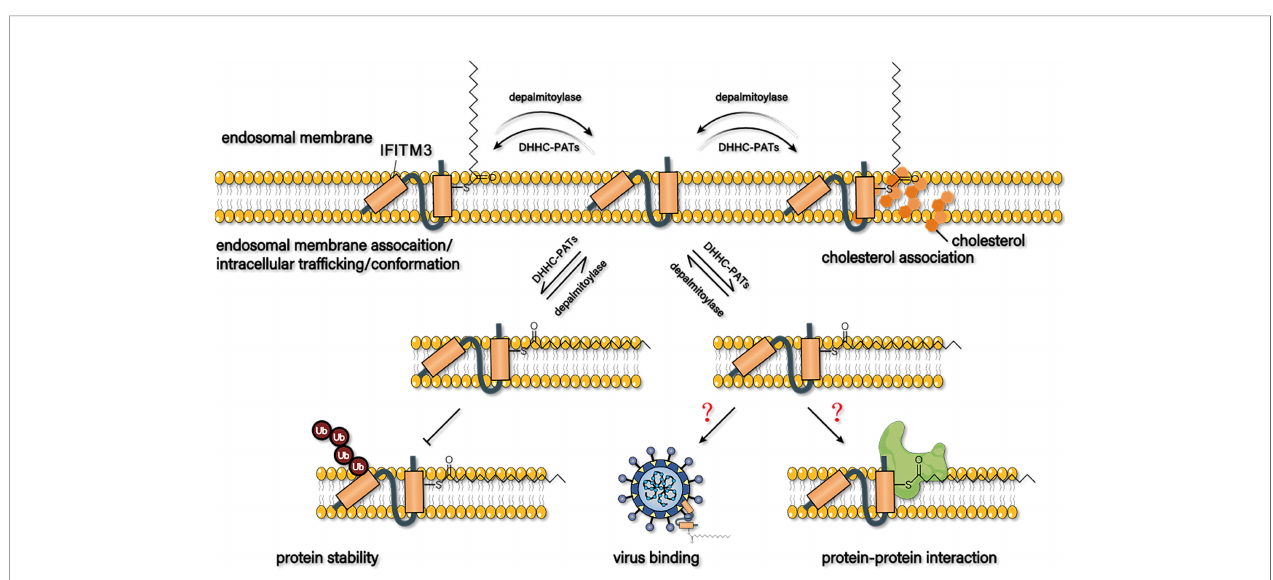
FIGURE 4 | Possible mechanism of s-palmitoylation to regulate the antiviral capacity of IFITM3. S-palmitoylation may affect its membrane proportion, traf fi cking to virions, stability, interaction with cholesterol, and conformation to regulate the antiviral activity of IFITM3. Whether S-palmitoylation affects the binding of IFITM3 to virus particles or its interaction with host proteins has not been reported